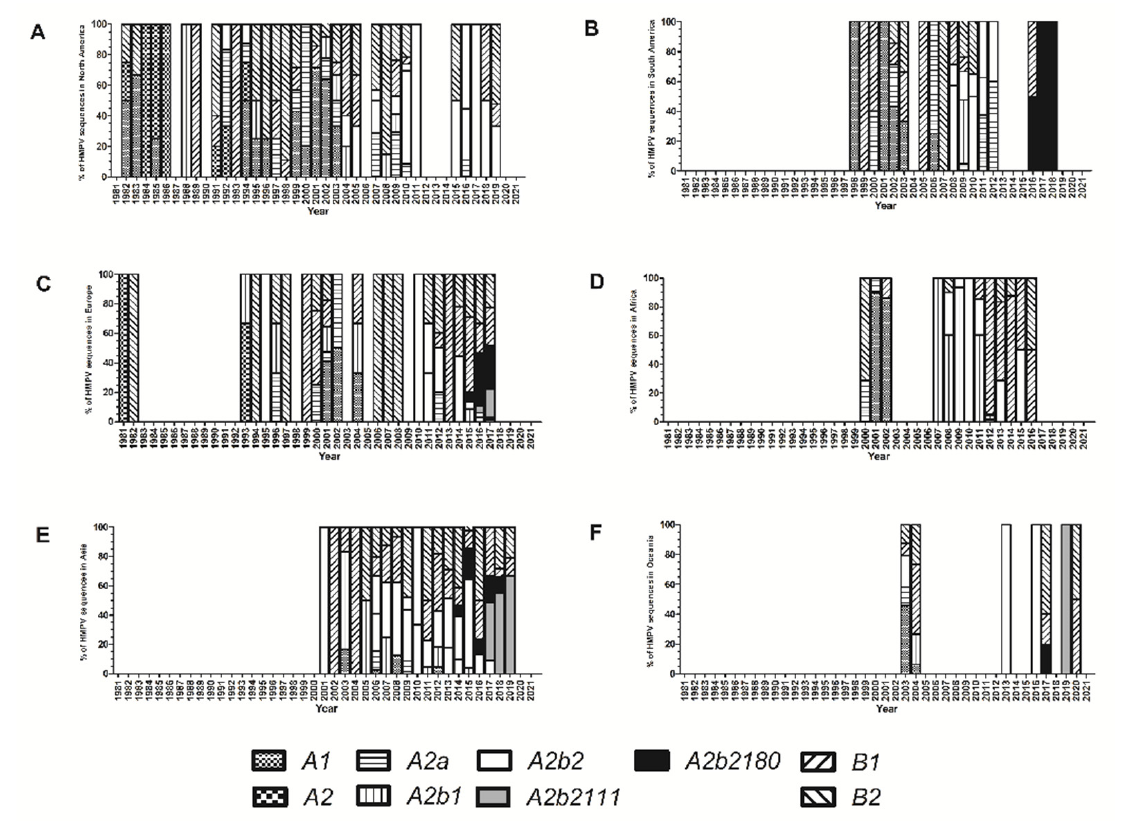
Figure 5. Proportion of human metapneumovirus (HMPV) sequences assigned to each genotype during each year in North America ( A ), South America ( B ), Europe ( C ), Africa ( D ), Asia ( E ), and Oceania ( F ) based on complete G gene ectodomain analysis for sequences available at GenBank up to December 2021.